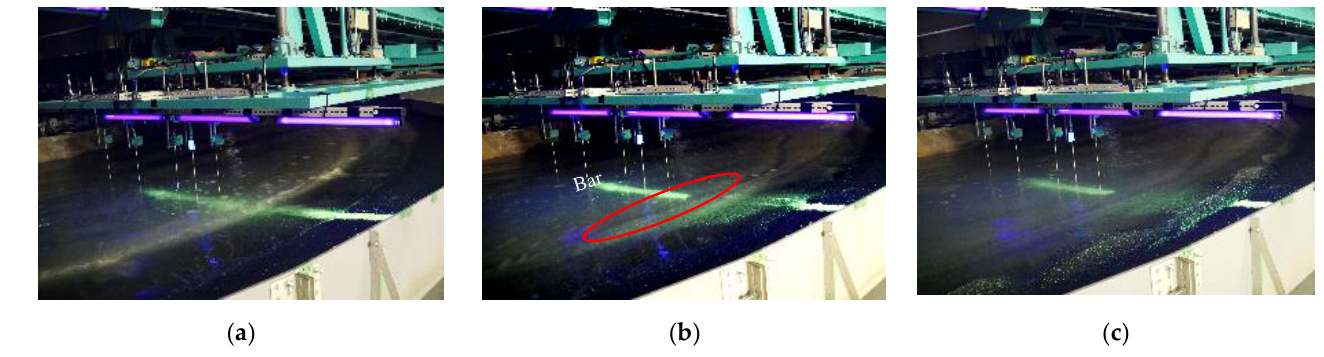
Figure 11. Snapshots of fluorescent sands movement during the experiment in Case 3: ( a ) after 1 min ( b ) after 10 min ( c ) after 60 min.